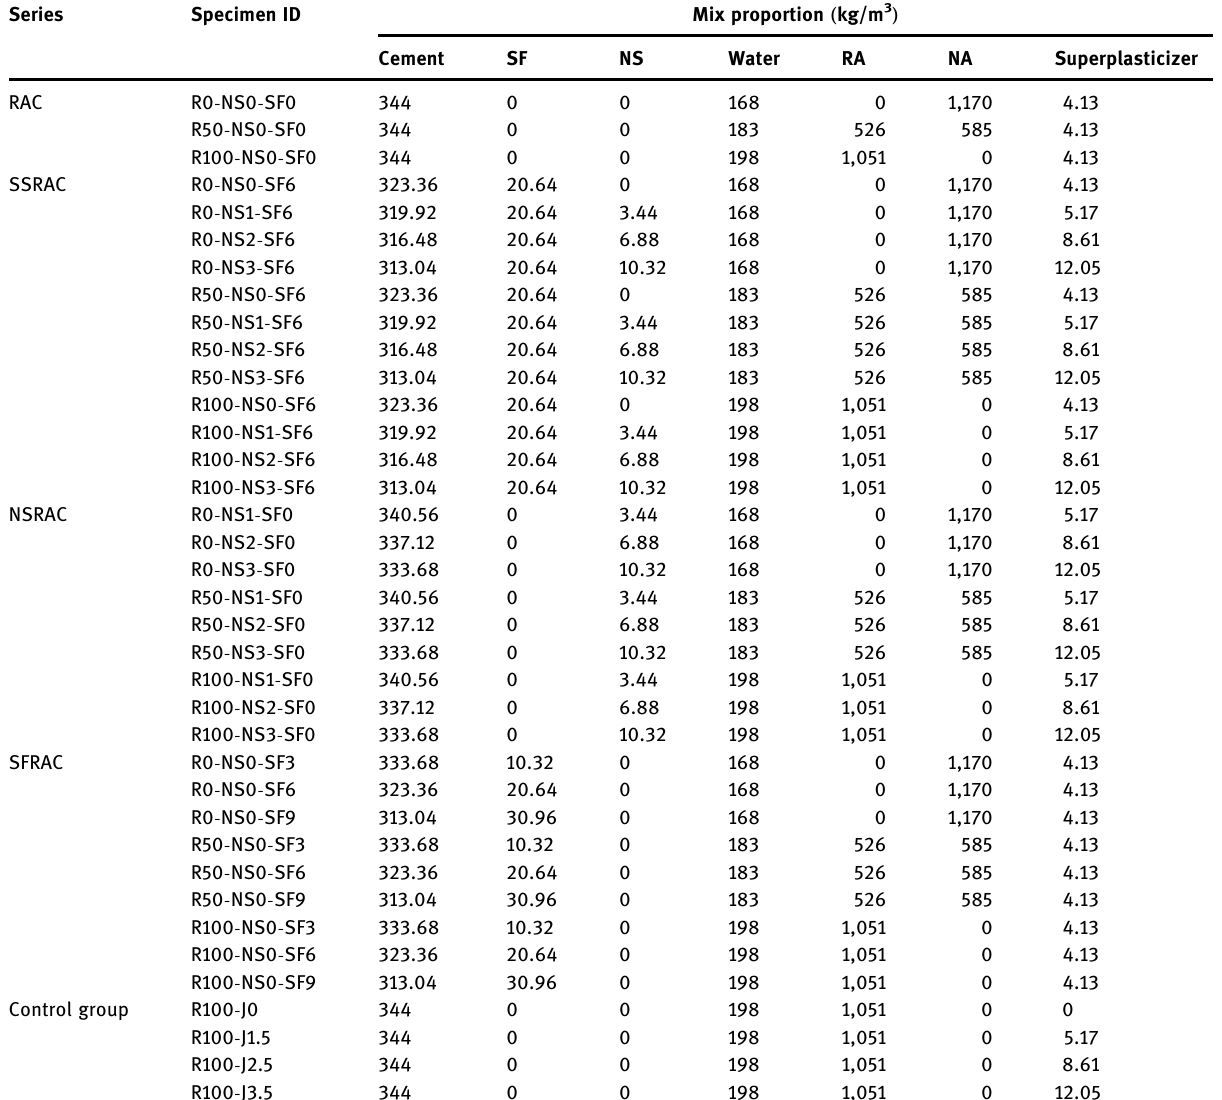
Table 4: Mix proportions